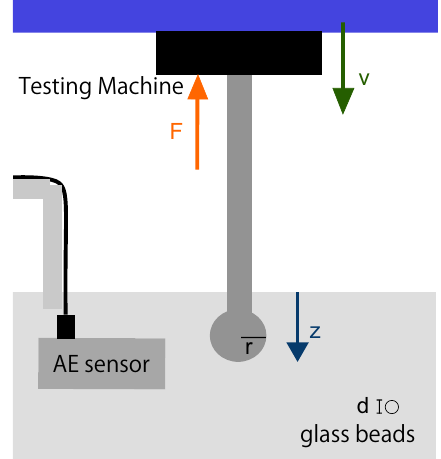
Fig. 1. Schematic illustration of the experimental setup. An AE sen- sor is buried in a glass bead bed (grain size d ). A sphere (radius r ) slowly penetrates into the bed. The exerted force F and AE ampli- tude A are